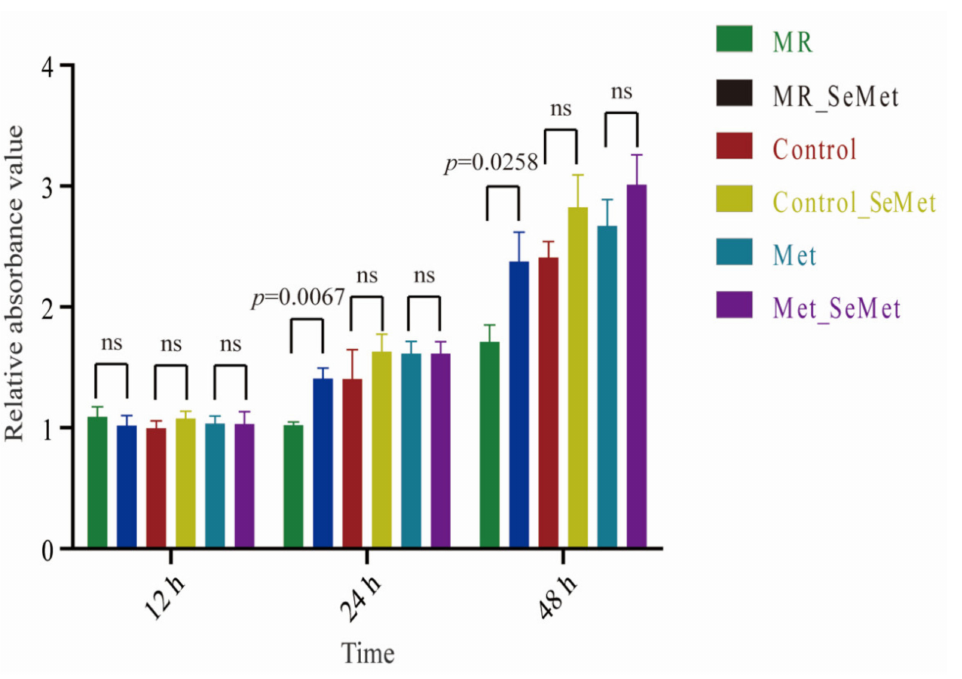
Figure 1. Cell viability of HepG2 cells exposed to SeMet under different Met supply conditions. Data are presented as mean ± SD; “ns” indicates not